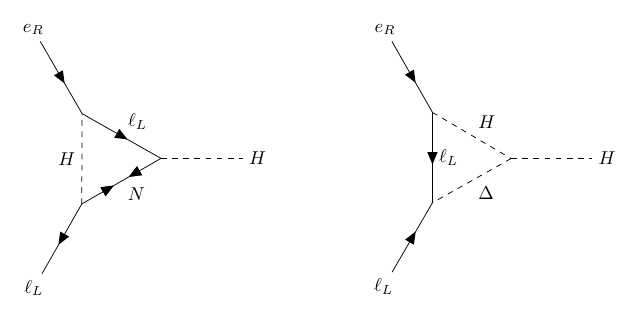
Figure 2 . Left: an illustrating diagram for generating operators seesaw model. Gauge bosons in operators O from heavy-mass expansion of the propagators in the loop. Right: a seemingly contributing but vanishing — due to the inconsistency in the fermion flow — diagram that could possible translate ‘ L into e R in the type-II model.